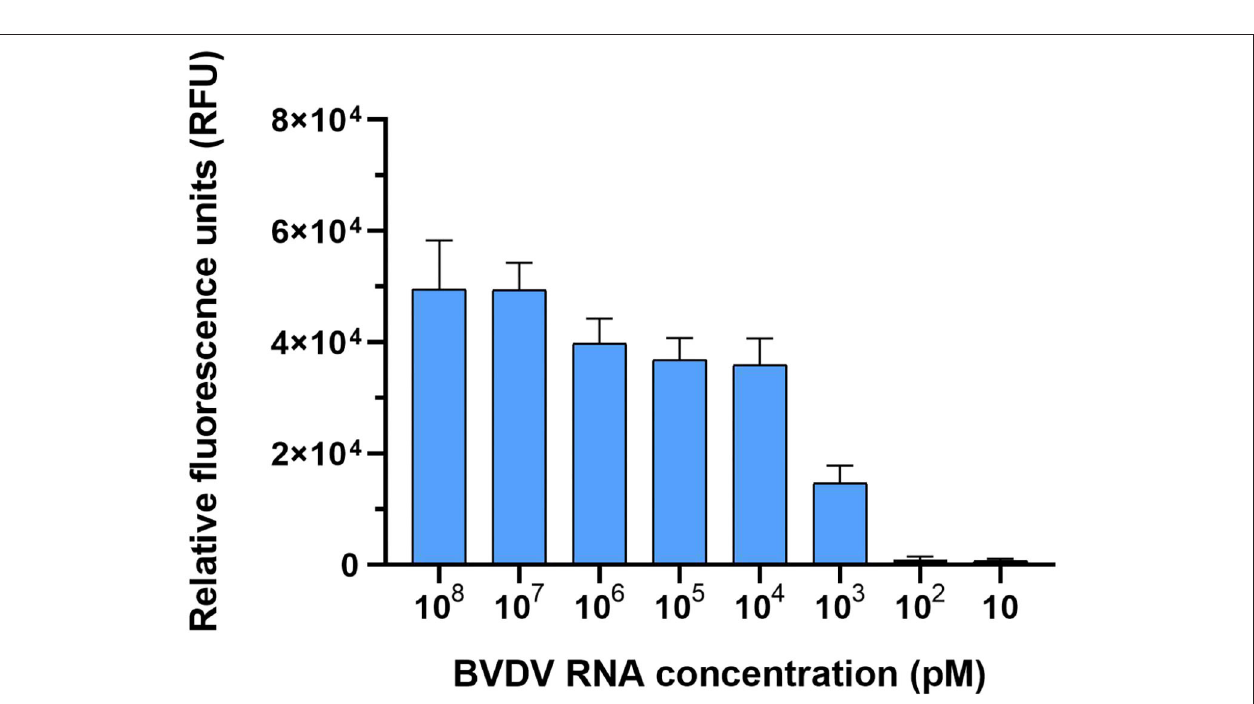
FIGURE 6 | Sensitivity of LwaCas13a detection. Sensitivity of LwCas13a fluorescence detection ( n = 3 technical replicates; values represent mean ± SEM).